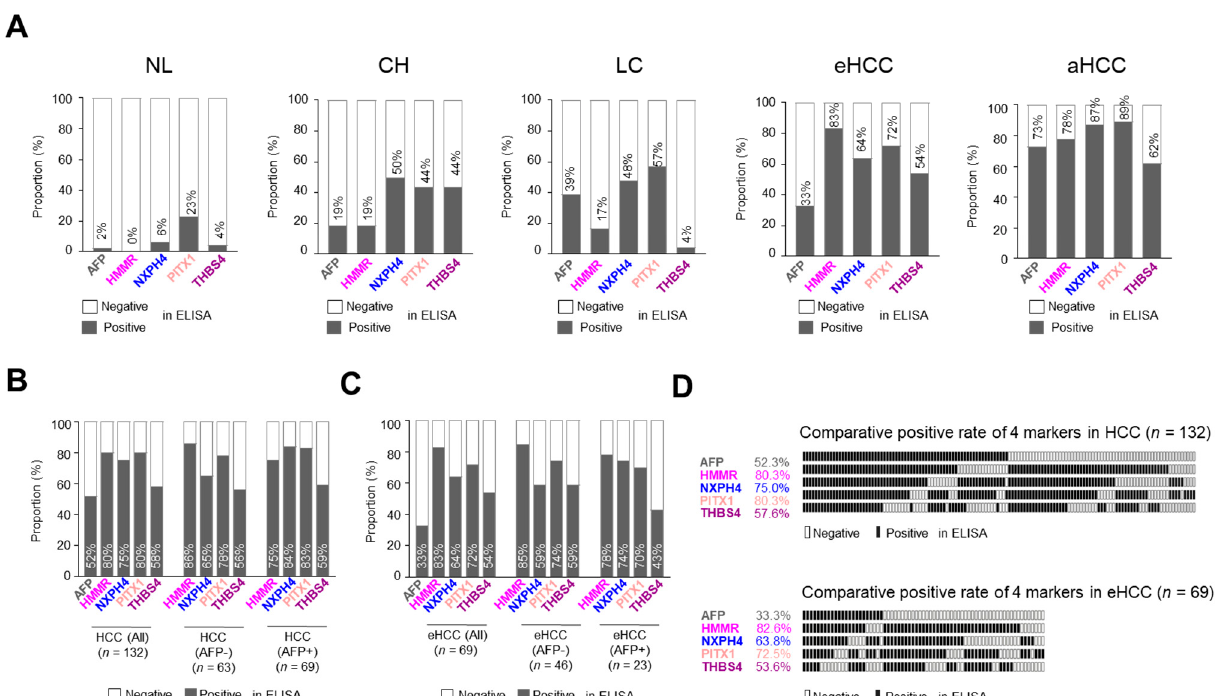
Figure 5. Diagnostic outcomes of four serum markers for the diagnosis of HCC and early-stage HCC. ( A ) The rate of patients with positive AFP and markers in each liver disease status. ( B ) The rate of patients with positive AFP and markers in all patients with HCC and for four markers according to AFP status in all patients with HCC. ( C ) The rate of positive patients for AFP and markers in patients with early-stage HCC and for markers by AFP status in patients with early-stage HCC. ROC, receiver operating characteristics. HCC, hepatocellular carcinoma. NL, normal liver. CH, chronic hepatitis B virus infection. LC, liver cirrhosis. ( D ) The bar chart showing rate with positive AFP and markers in all patients with HCC ( upper panel) and patients with early-stage HCC ( lower panel).